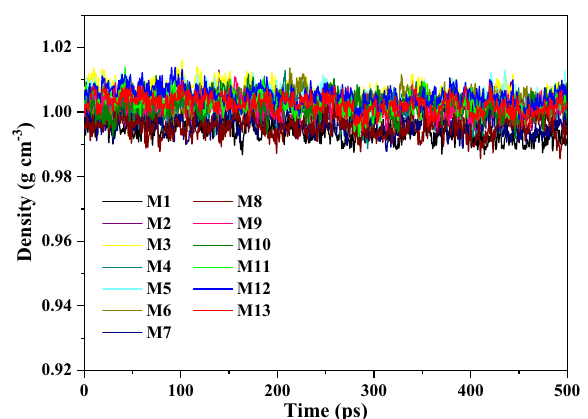
Fig. 1 Density of the unaged and aged PDMS models as a function of simulation time.